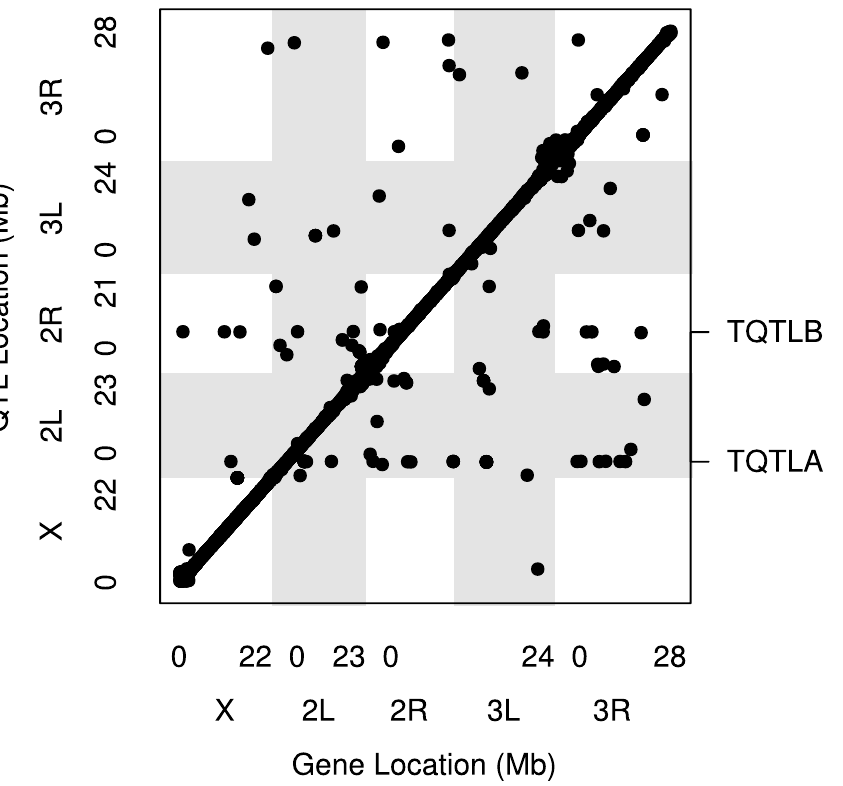
Figure 1. The locations of all mapped eQTL. The location of the transcripts whose expression measures are mapped are along the x axis and the location of the corresponding eQTL peaks are along the y axis. Points falling along the diagonal indicate eQTL mapping to the same location as transcripts ( cis ) while those off the diagonal map to different locations ( trans ). The clusters of points near each centromere are within 1.5 cM of the target gene ( cis ) but are further away in physical distance due to the low recombination rate and lower mapping resolution in this region. Grey and white shading denote the different chromosome arms. The two trans hotspots we identified are labeled on the right axis (See Figure 4).